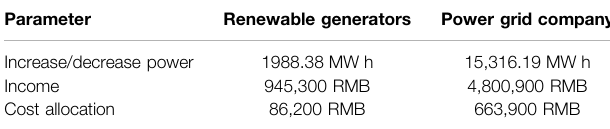
TABLE 3 | Allocation results of user compensation costs for each bene fi ciary